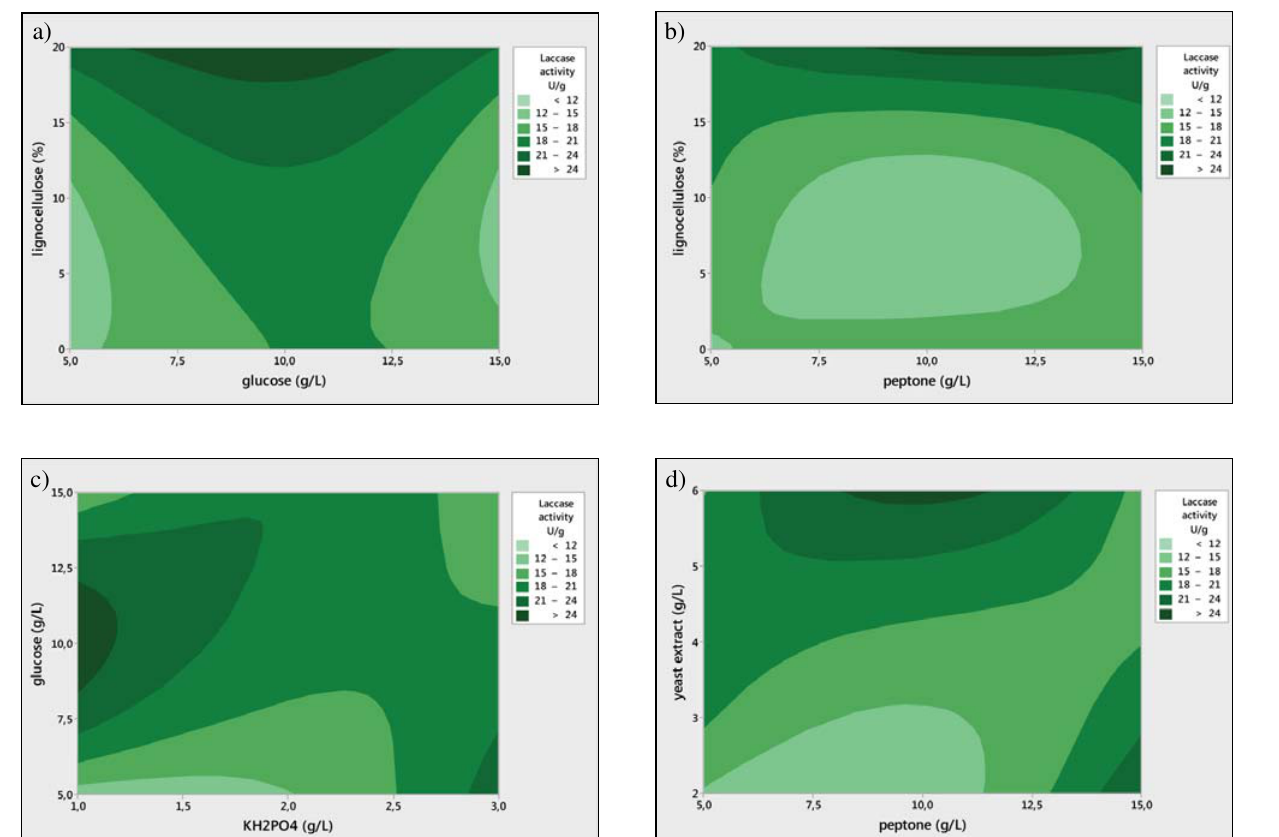
PO and (d) yeast extract and pep- 2 4